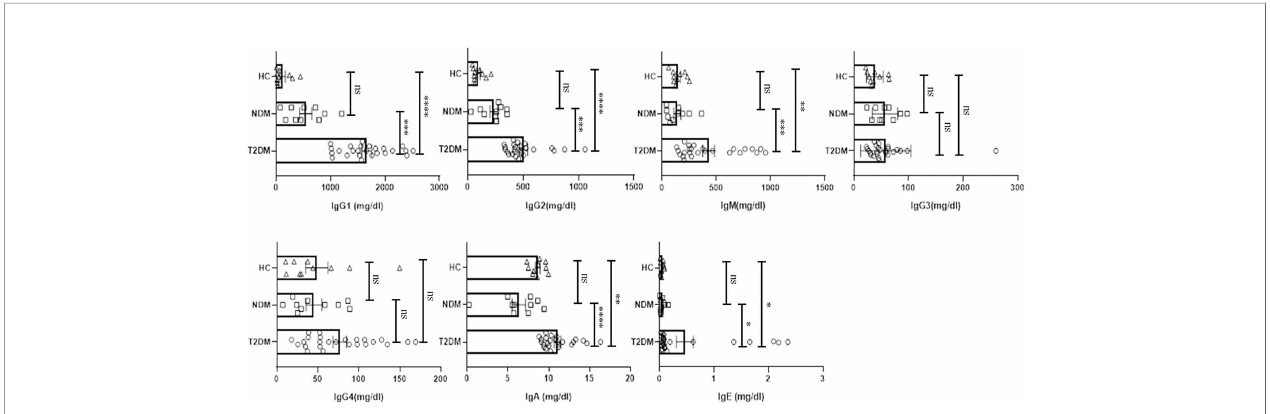
FIGURE 3 | Analysis of the circulating antibodies in T2DM, NDM patients infected with SARS-CoV2. The bar diagram representing circulating antibody isotypes (IgA, IgM, IgG1, IgG2, IgG3, IgG4, and IgE) which were evaluated from COVID -19 positive plasma samples of T2DM (n = 25), NDM (n = 10), and Covid-19 negative and non-diabetic healthy controls (n = 10). The Kruskal Wallis Test (non-parametric) with post-hoc Dunn ’ s multiple comparison test was performed. p < 0.05 was considered to be statistically signi fi cant (*), p < 0.01 was considered to be very signi fi cant (**), P < 0.001 was considered to be highly signi fi cant (***), P < 0.0001 was considered to be extremely signi fi cant (****), ns, not signi fi cant. All error bars were